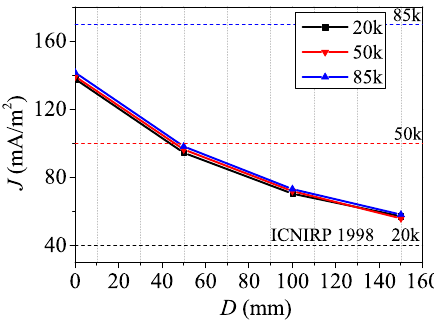
Figure 13. Curves of surface current density of the human body versus distance at various